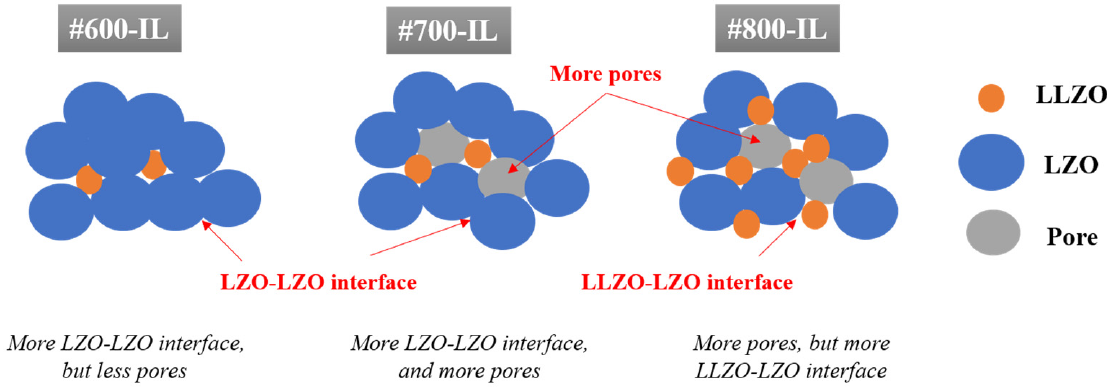
Figure 7. The model of LLZO – LZO interface enhancing the ionic conductivity.